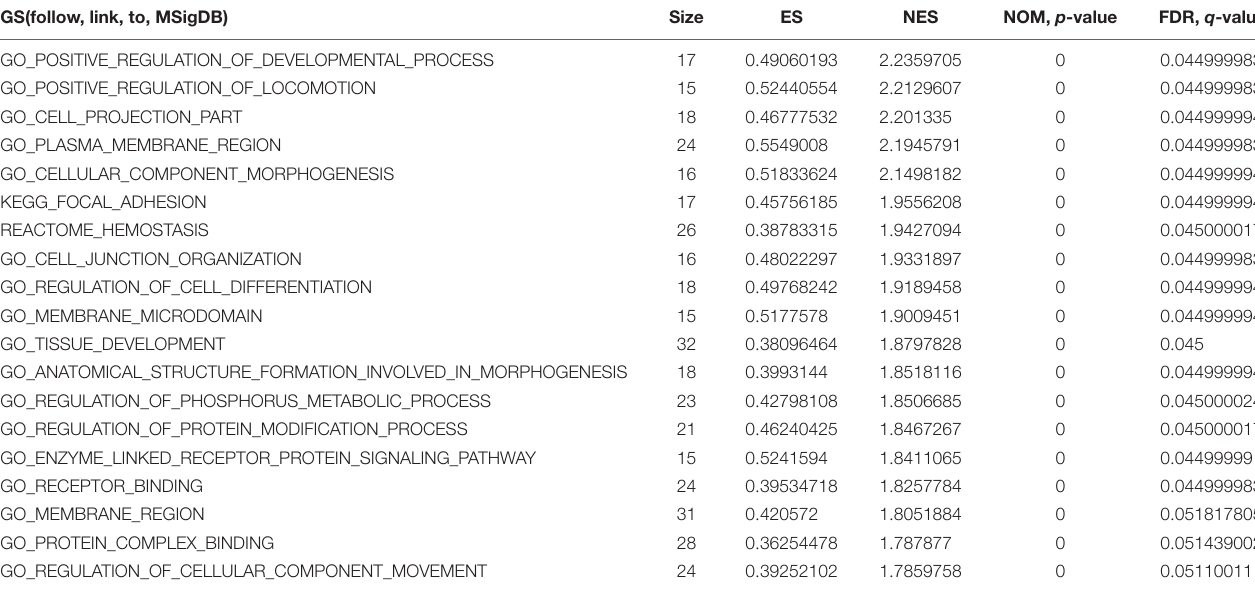
TABLE 1 | Gene set enrichment result of differentially expressed membrane proteins. GS(follow, link, to,